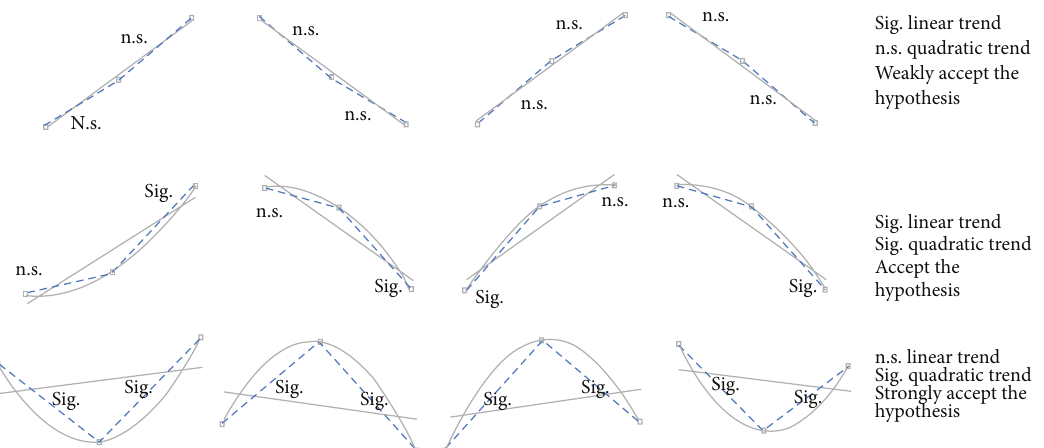
Figure 5: Schema of the listed situations and graphical representations of the linear-quadratic trend coexistence. Here, we illustrate linear or quadratic relationships among the three states regardless of Cartesian representation.